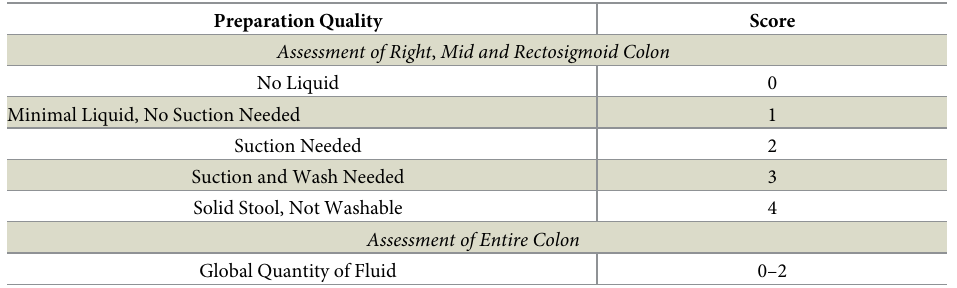
Table 1. Ottawa bowel preparation